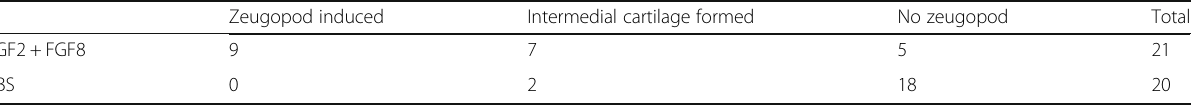
Table 1 Fgf-mediated intercalary responses in st. 24 chicken limb